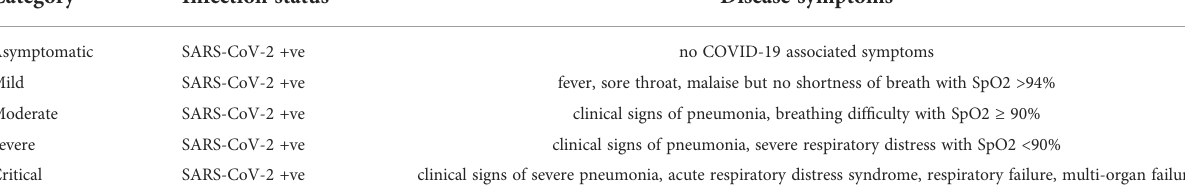
TABLE 1 Classi fi cation of COVID-19 disease severity sub-phenotypes.